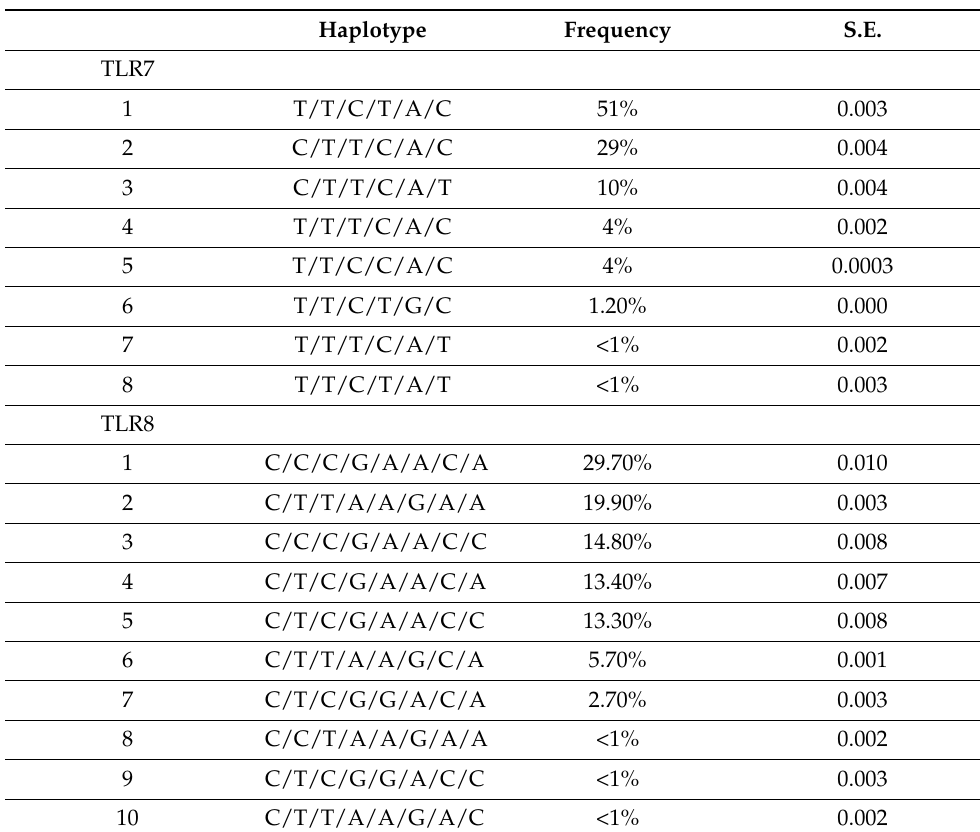
Table 5. The haplotypes frequency of TLR7 and TLR8